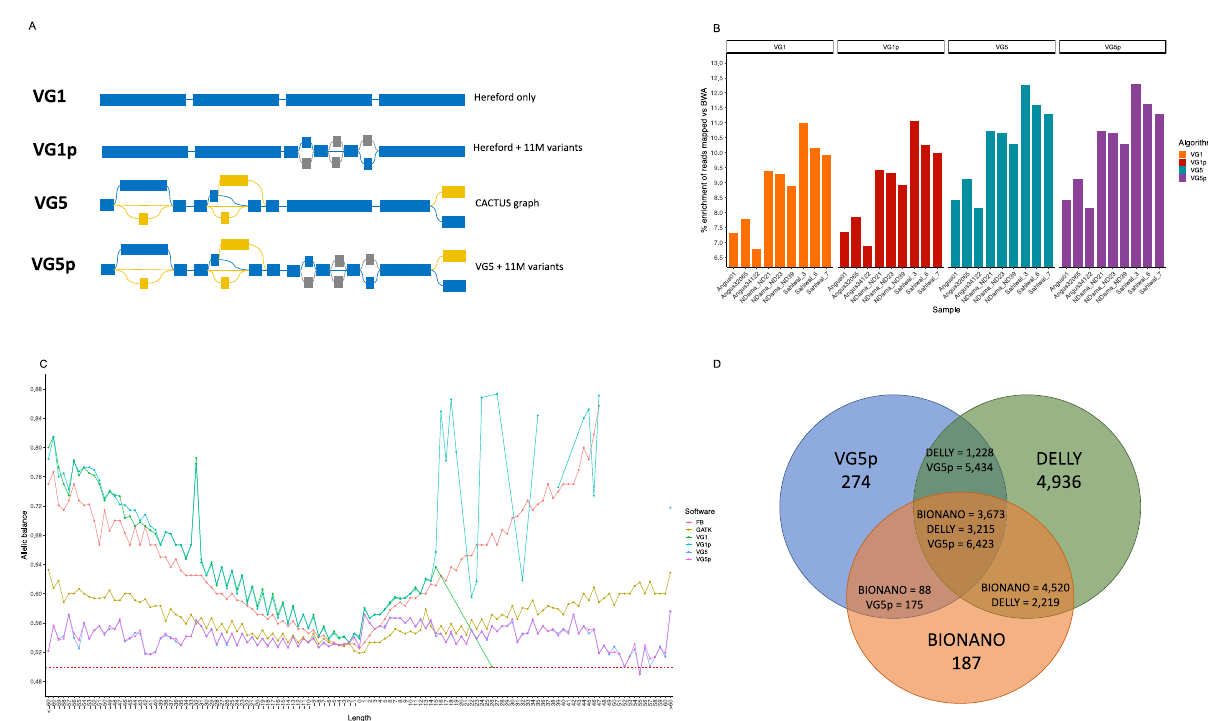
Fig. 4 Graph genome descriptions and their performances. A A cartoon representation of the four types of graph genomes considered (the linear VG1, VG1 expanded with 11 M short variants (VG1p), the CACTUS VG5 graph and the CACTUS graph expanded with the 11 M short variants (VG5p)). Regions indicated in blue are regions coming from the backbone sequence, those in grey are the short variants from Dutta et al. (2020), and in yellow the variants derived from the CACTUS graph; B the percent enrichment of reads mapped by vg (primary axis) using the different graphs over the bwa mem linear mapper; and C the allelic balance for the linear callers FreeBayes and GATK HaplotypeCaller compared with vg call, showing how the latter reduces the allelic bias for large variants. For other versions of this plot looking at different sets of known and novel variants see Supplementary Note 3; and D the intersection of structural variants longer than 500 bp called using the VG5p graph (blue), Delly V2 (green) and the Bionano optical mapping (orange), showing how most variants called with vg are also con fi rmed using one of the other methods. Note an SV called by one method may overlap more than one SV called by a different method. The source data for panels ( B ), ( C ) and ( D ) are provided with the